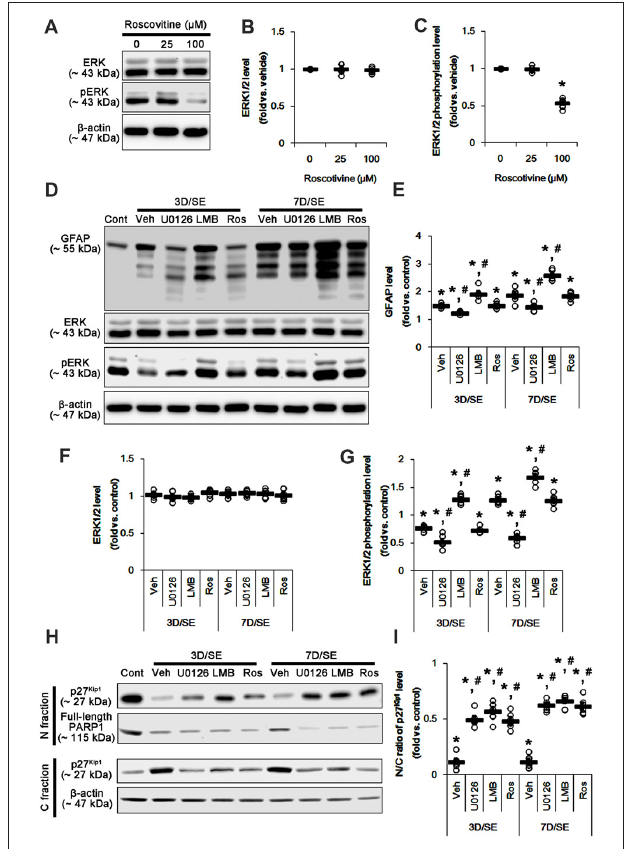
FIGURE 2 | Effects of U0126, LMB and roscovitine on GFAP, ERK1/2, phospho (p)-ERK1/2 and p27 Kip1 levels following SE. (A–C) Effect of roscovitine on ERK1/2 phosphorylation in control animals. (A) Representative images for western blot of ERK1/2 and pERK level expression in the hippocampal tissues. (B,C) Quantifications of EKR1/2 (B) and pERK1/2 (C) intensity. Open circles indicate each individual value. Horizontal bars indicate mean value. Error bars indicate SEM ( ∗ , # p < 0.05 vs. control and vehicle, respectively; n = 7, respectively). (D–G) Effects of U0126, LMB and roscovitine on GFAP, ERK1/2 and pERK1/2 levels 3-day and 7-day post-SE animals. (D) Representative images for western blot of GFAP, ERK1/2 and pERK1/2 level in the hippocampal tissues. (E–G) Quantifications of GFAP (C) ERK1/2 (D) and pERK1/2 (E) intensity. Open circles indicate each individual value. Horizontal bars indicate mean value. Error bars indicate SEM ( ∗ , # p < 0.05 vs. control and vehicle, respectively; n = 7, respectively). (H,I) Effects of U0126, LMB and roscovitine on subcellular p27 Kip1 level 3-day and 7-day post-SE animals. (H) Representative images for western blot of p27 Kip1 level in nuclear (N) and cytosolic (S) fractions. (I) Quantifications of the ratio of p27 Kip1 level in nuclear and cytosolic fractions. Open circles indicate each individual value. Horizontal bars indicate mean value. Error bars indicate SEM ( ∗ , # p < 0.05 vs. control and vehicle, respectively; n = 7,